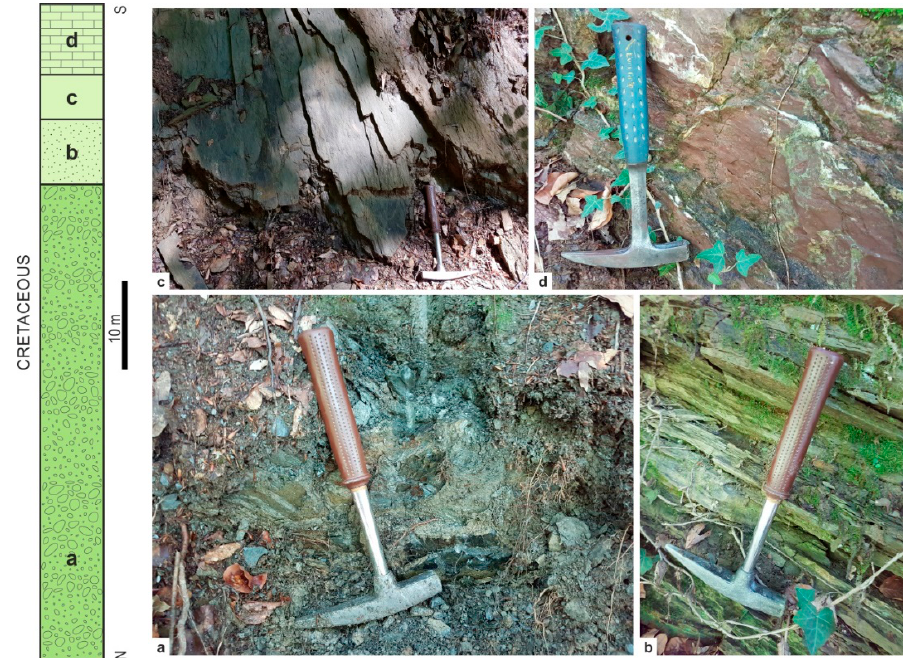
Figure 11. Field photographs of: ( a ) conglomerates; ( b ) sandstones; ( c ) shales and ( d ) the Scaglia Limestones between Mali Potok and Veliki Potok Creeks, studied by [10,30], revisited during this study. Position in the stratigraphic succession described by [10] marked on a schematic column.